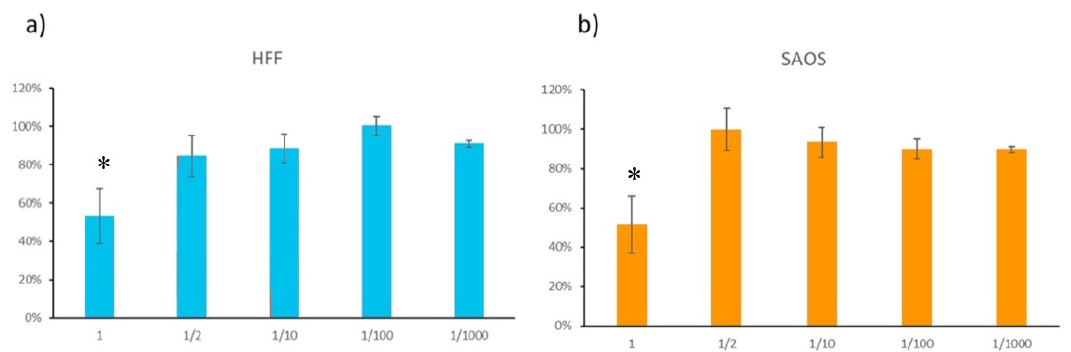
Figure 6. Cell viability in the cytotoxicity assay with HFF-1 ( a ) and SAOS-2 cells ( b ). * means that the sample had cytotoxic effect (loss of <70% of cell viability).